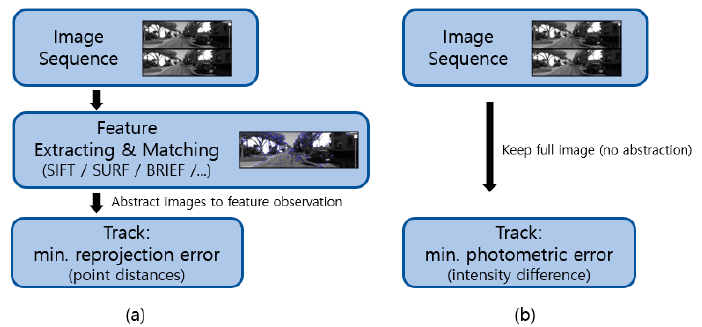
Figure 1. The process of Visual Odometry (VO) methods: ( a ) feature-based VO method and ( b ) direct VO method [5].